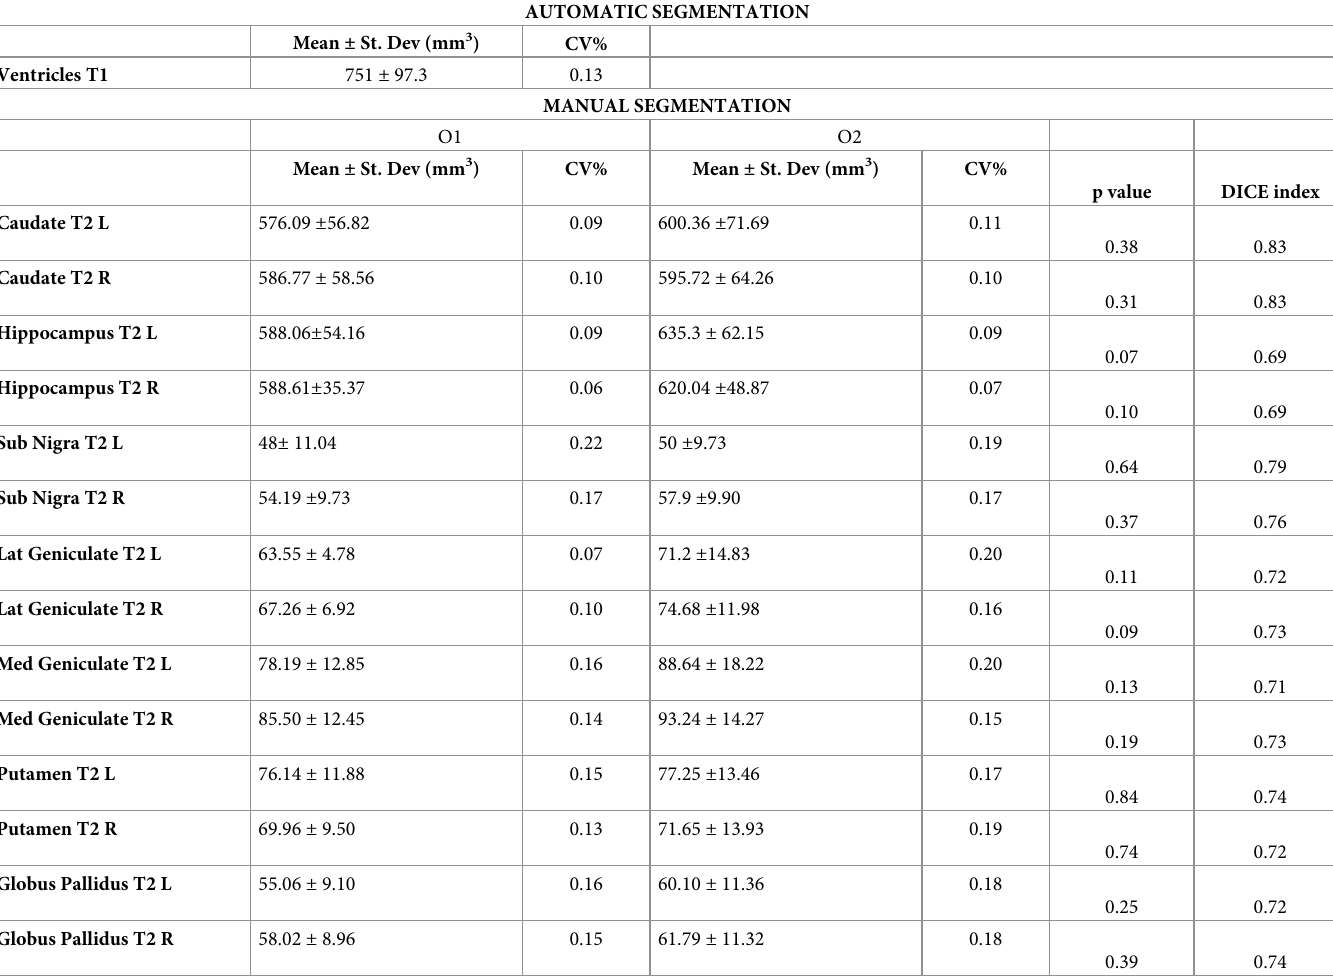
Table 1. Summary table for the sample of 11 dogs. Estimated volumes of the segmented structures from operators 1 and 2 (O1/O2), expressed as the volume averaged across the considered subjects, their standard deviation, and CV. For the ventricles, we report the values obtained from the automatic segmentation, since this outper- formed the manual approach. The Dice similarity index shows a good agreement between the two operators, corresponding to an average Dice index of